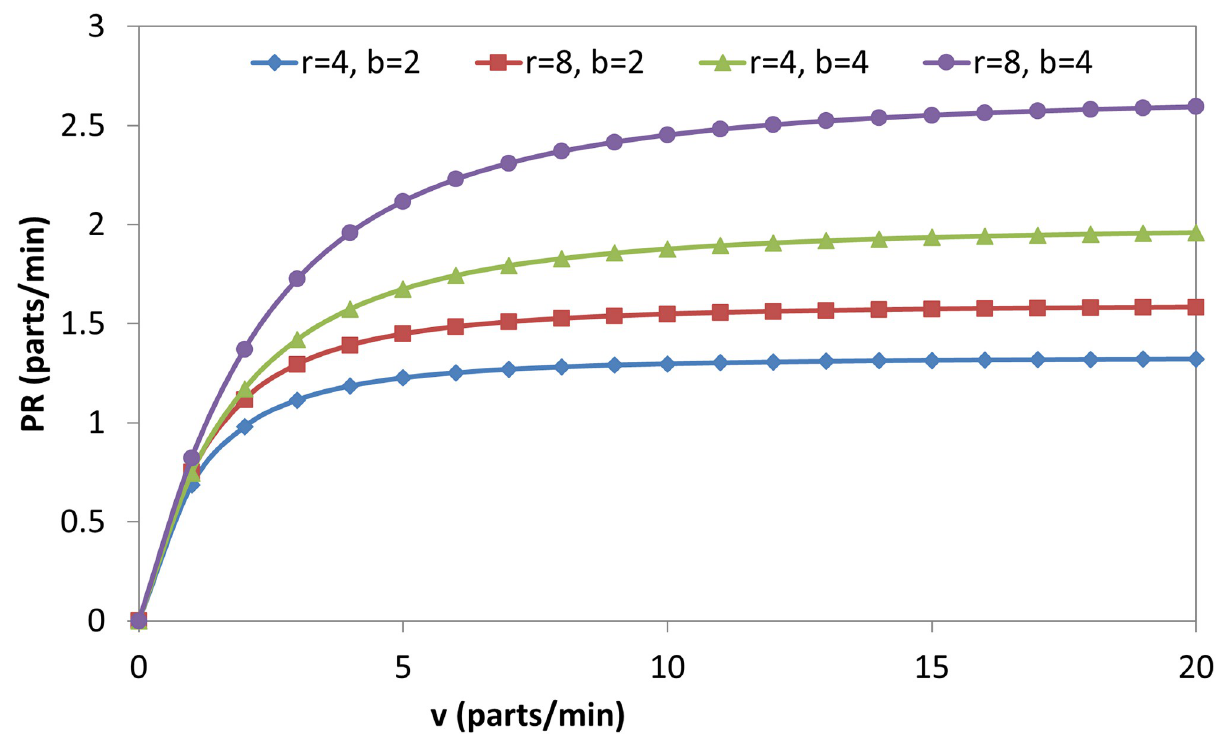
Fig 11. PR-v diagram for single-machine FMC. https://doi.org/10.1371/journal.pone.0259247.g011 PLOS ONE | https://doi.org/10.1371/journal.pone.0259247 February 1,